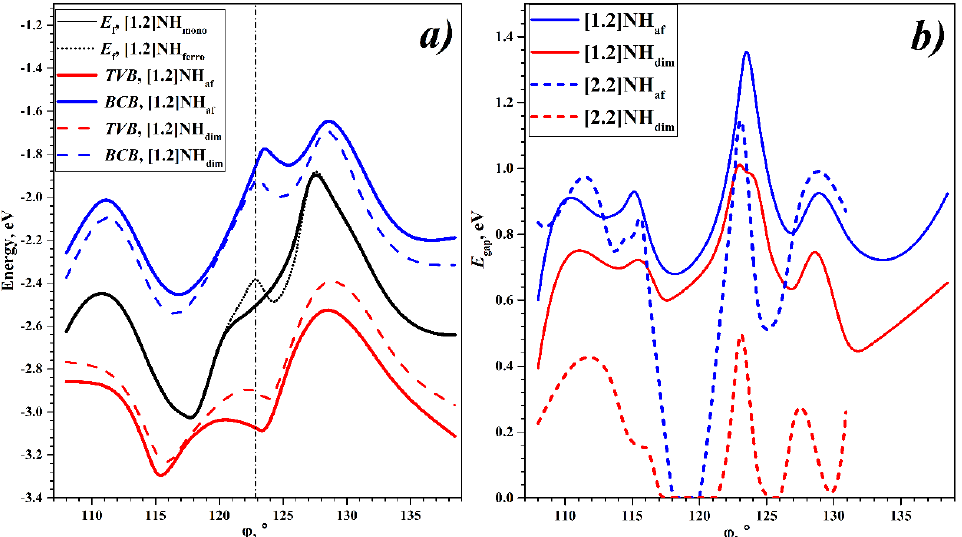
Figure 5. ( a ) Torsion dependence of E f , TVB, and BCB of [1.2]helicene’s states. ( b ) Torsion dependence on BG values, E gap , of the [1.2]helicenes and [2.2]helicenes.